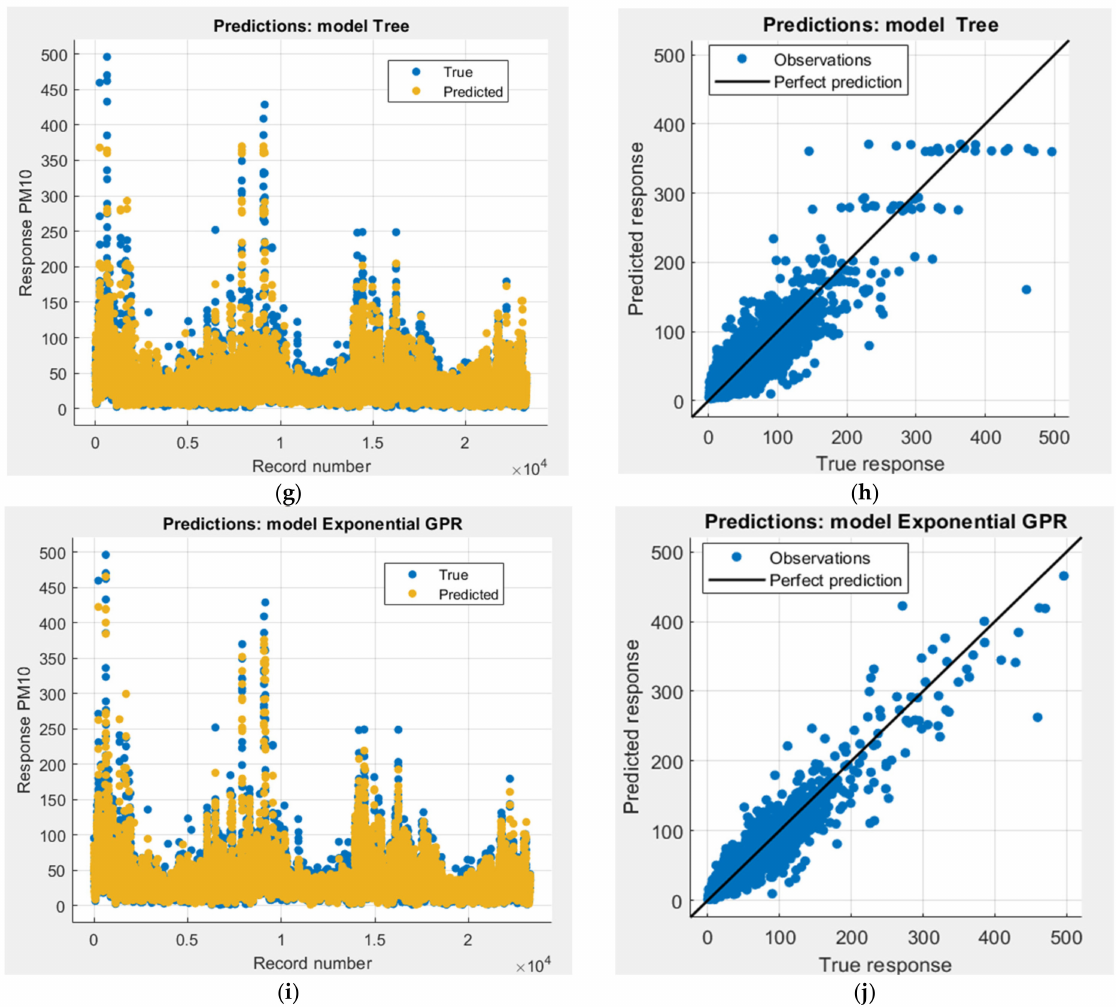
Figure 2. Response plot graphs for the models ( a ) LR, ( c ) KNNR, ( e ) SVM, ( g ) RT and ( i ) GPR, and the predicted response versus true response graphs for the models ( b ) LR, ( d ) KNNR, ( f ) SVM, ( h ) RT and ( j ) GPR, respectively.